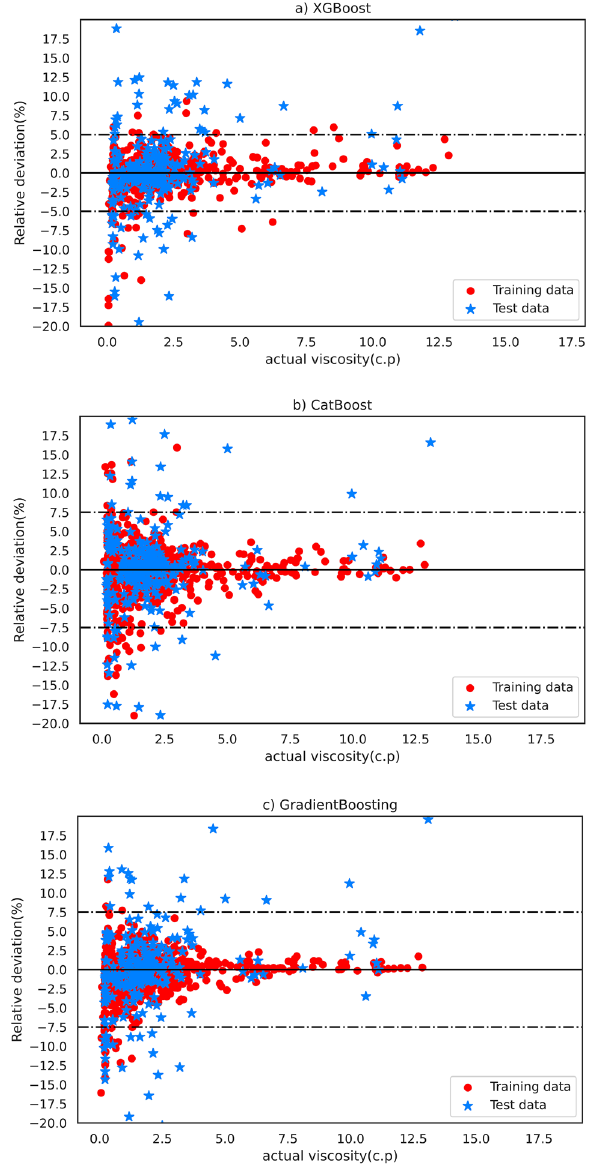
Figure 4. Relative deviation (%) of estimated viscosity values using the ( a ) XGBoost, ( b ) CatBoost, and ( c ) GradientBoosting model for test and train data